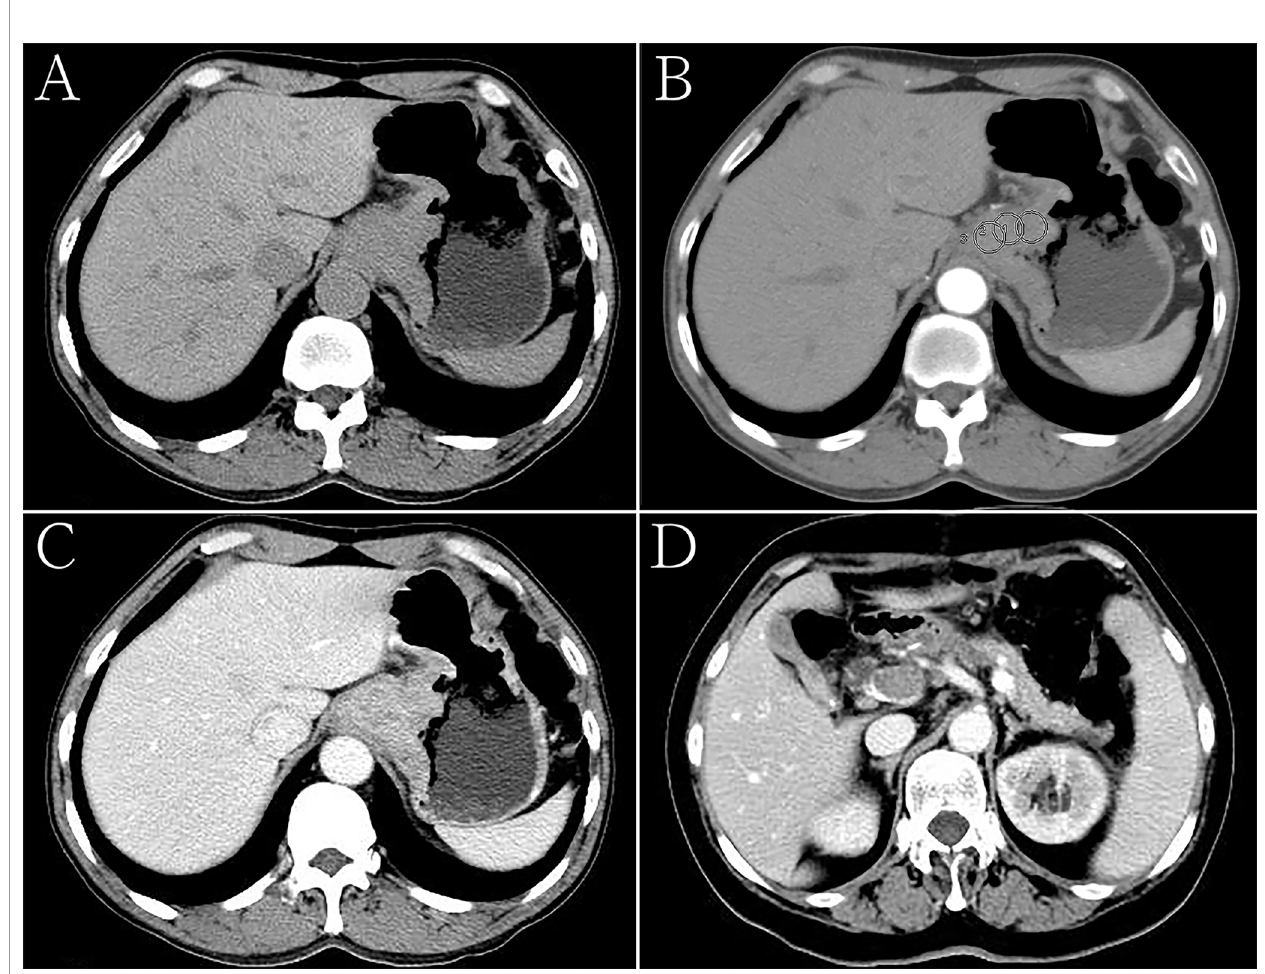
FIGURE 2 | Hepatoid adenocarcinoma of the stomach in a 60-year-old woman. (A) Unenhanced computed tomography (CT) image of the stomach showing an intraluminal mass of homogeneous attenuation, with an irregular surface, in the cardia and fundus. The CT attenuation was approximately 52 Houns fi eld units (HU). (B – D) Contrast-enhanced CT image showing moderate inhomogeneous enhancement of the mass, with the peak value observed in the portal phase. The thickest diameter of the mass was 4.7 cm. Ulceration was seen on the surface of the lesion. The Borrmann classi fi cation was type III. The CT attenuation in the arterial and venous phases were approximately 69 and 89 HU, respectively. Low-density tumor thrombi can be seen in the portal vein. (B) Arterial phase of the contrast- enhanced image, the CT attenuation were measured with regions of interests (ROIs) that were drawn manually, each with a diameter of about 15 mm 2 , while carefully avoiding vessels as well as necrotic and artifactual areas. The ROIs were measured at least three times and the average values were taken. (C, D) Portal phase of the contrast-enhanced